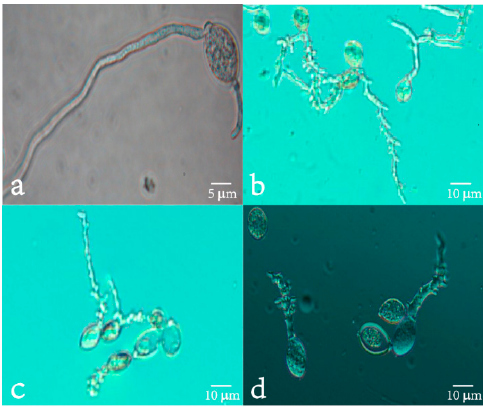
Figure 3. Micrographs of the sporangia germination of P. litchii Chen with or without isoliquiritin. ( a ) Control; ( b ) 30 mg/L; ( c ) 50 mg/L, and ( d ) 70 mg/L.